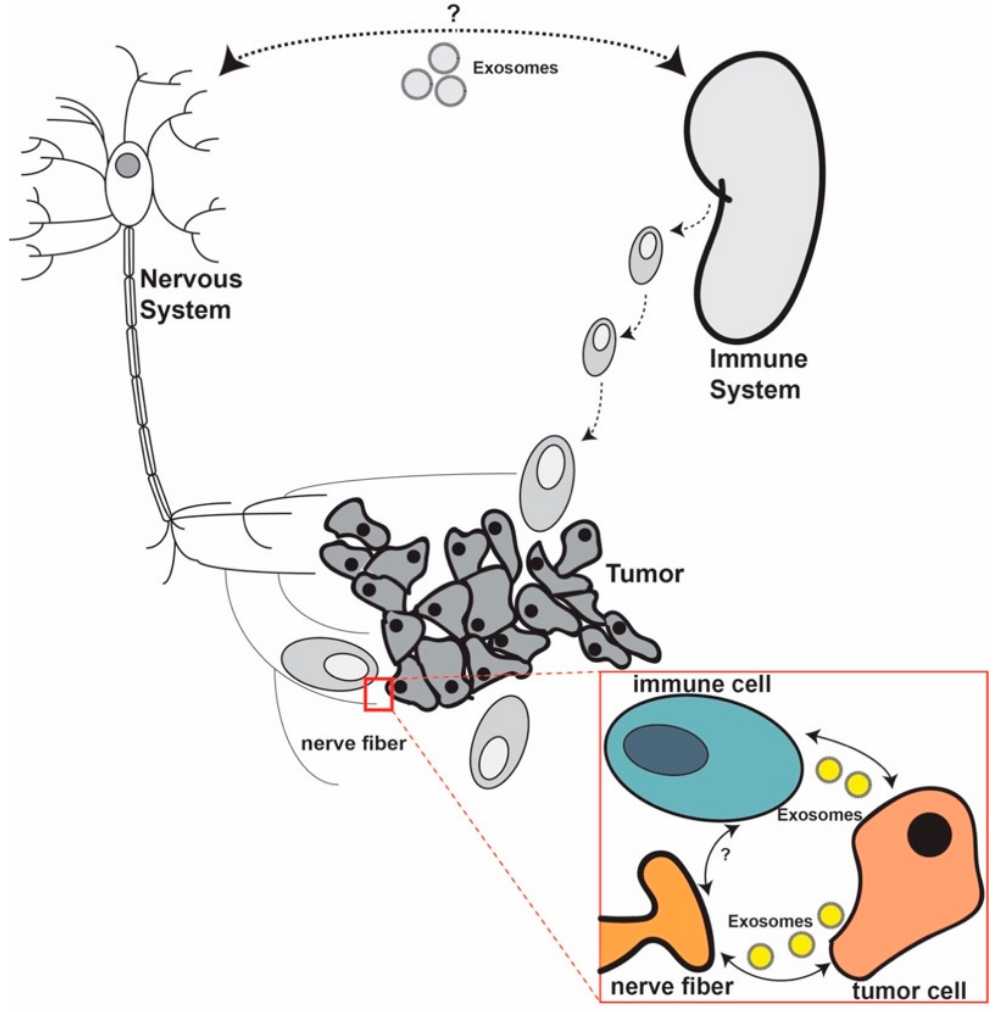
Figure 1. We hypothesize that a direct crosstalk between nerves and immune cells in cancer exists. This crosstalk might occur both at the systemic and within the tumor microenvironment (TME) (red box) levels. At a systemic level, the crosstalk may be mainly mediated by neurotransmitters and cytokines, but molecular mechanisms are needed to be further examined. At the TME level, the interplay between the three components can be either direct, through ligands, or indirect. We speculate that exosomes play an important role in this communication both at the systemic level and in the TME.